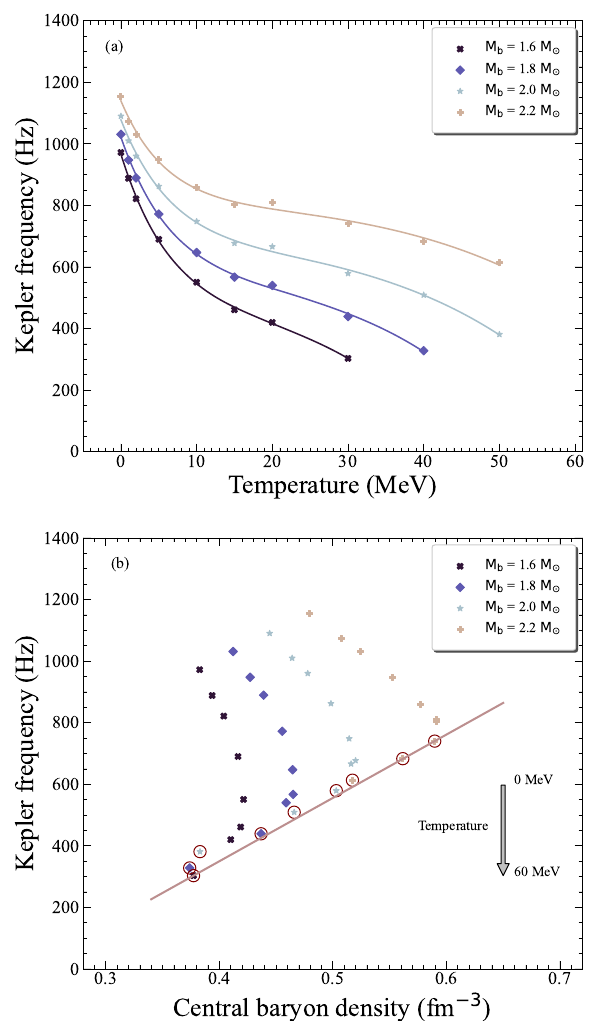
Figure 4. The Kepler frequency as a function of (a) the tempera- ture and (b) the central baryon density for constant baryon mass sequences. (a) Solid lines correspond to fits (for more details see Ref. [15]). (b) The solid line corresponds to Equation (1) and open circles mark the high-temperature region ( T ≥ 30